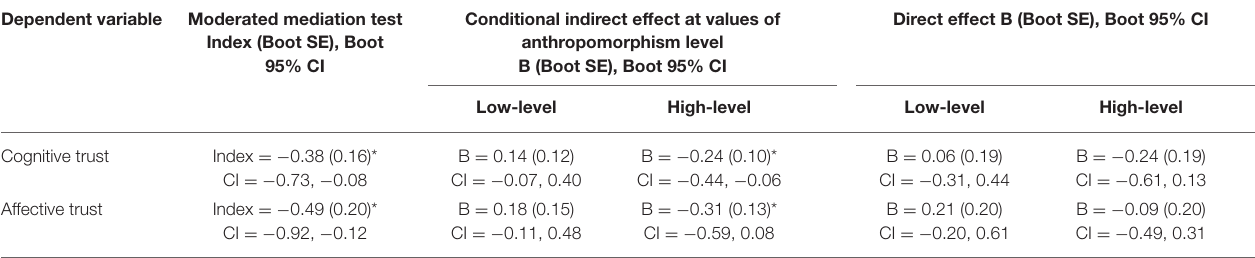
TABLE 2 | Results of moderated mediation test.